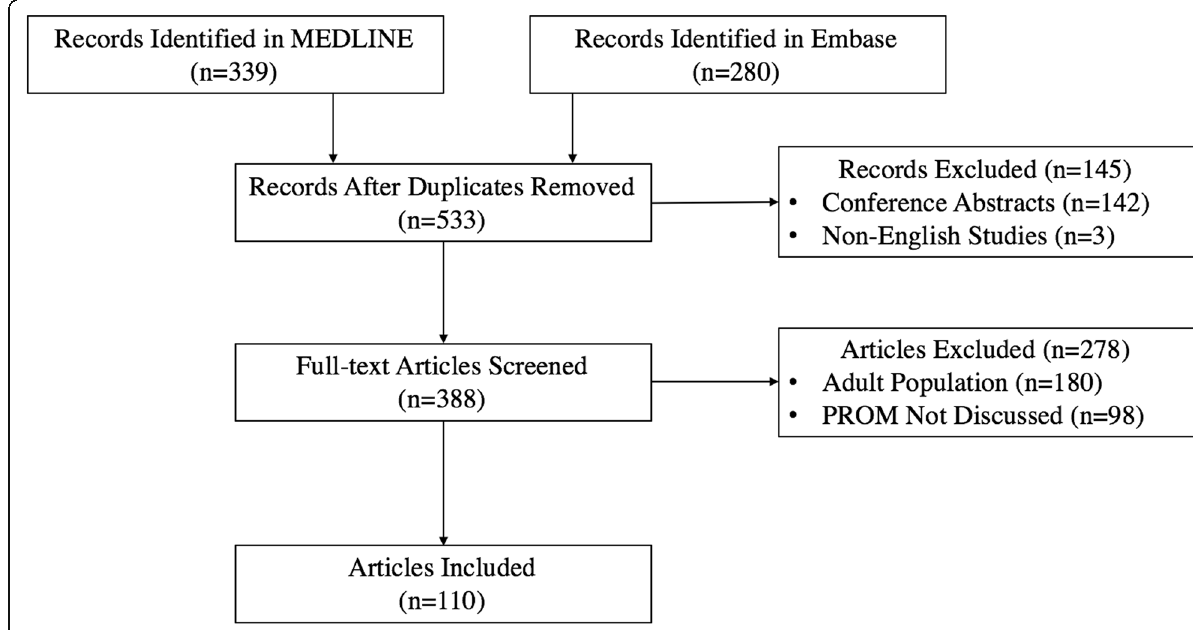
Fig. 1 Process of study selection, consort diagram. Unique articles identified by comprehensive database searches ( n = 533) were screened by title and abstract against inclusion and exclusion criteria. Full text articles ( n = 388) were then reviewed against inclusion and exclusion criteria. Full-text review resulted in 110 included